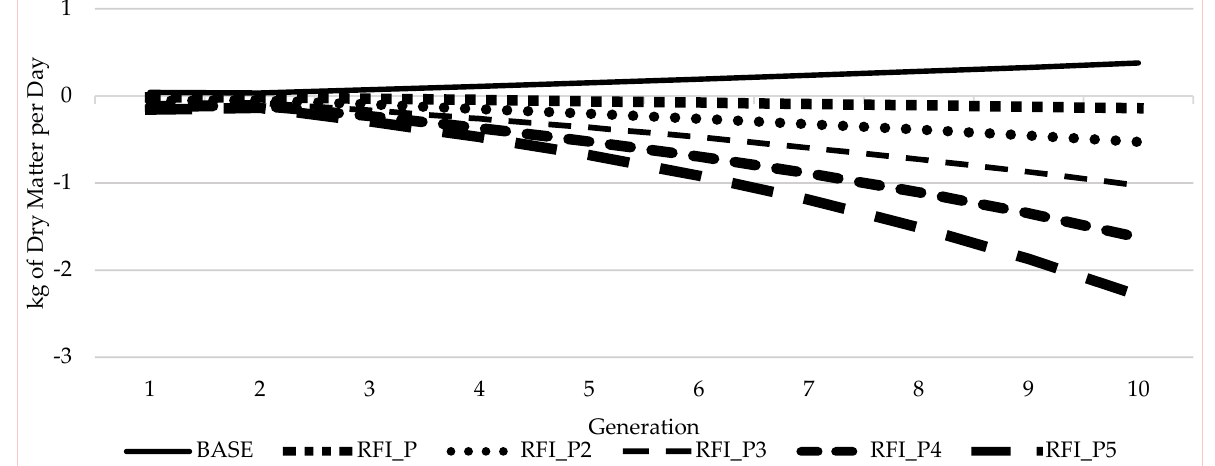
Figure 2. Cumulative response to selection for dry matter intake per day based on different weights of selection pressure on RFI over 10 years.